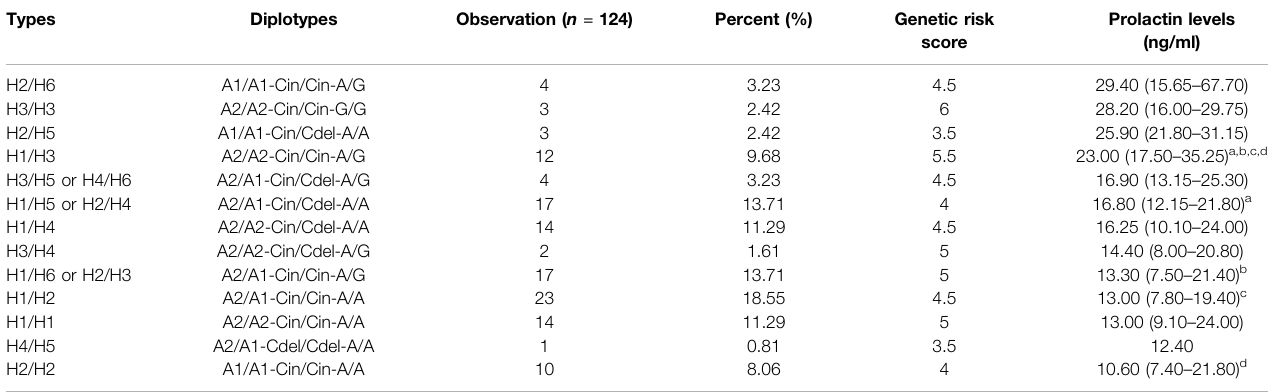
TABLE 3 | Associations between DRD2 gene diplotypes and serum prolactin levels.